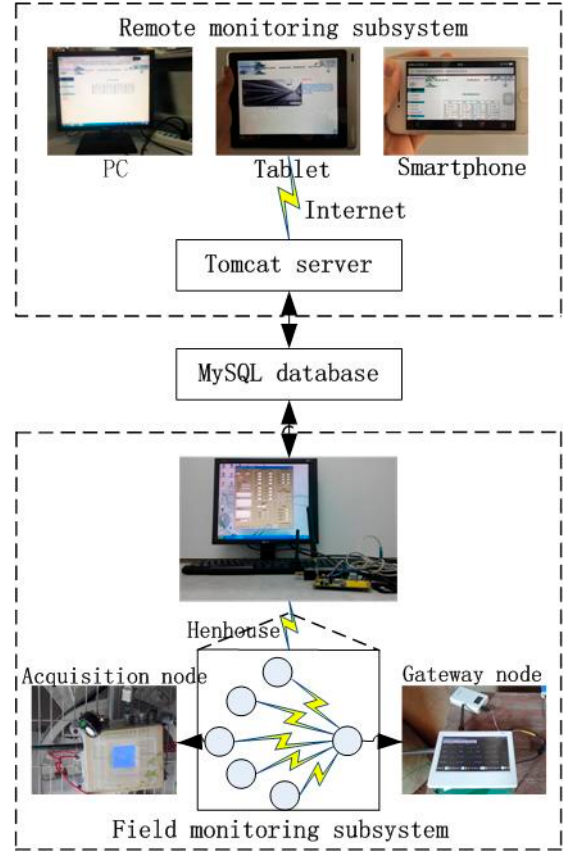
Figure 1. Overall design of the remote monitoring system for